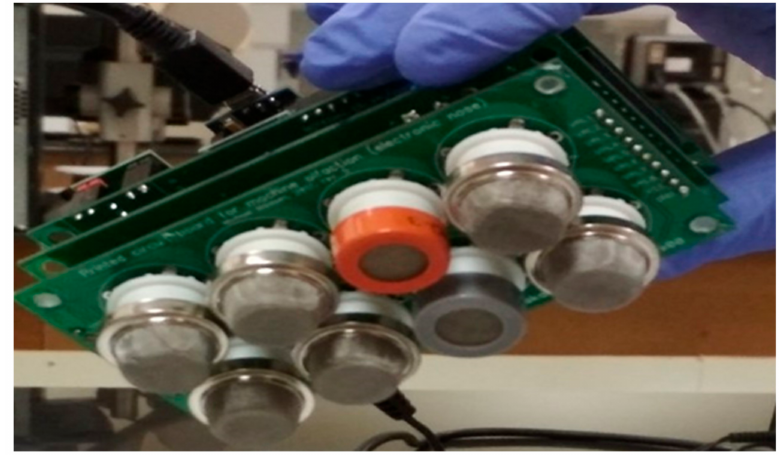
Figure 1. The prototype electronic nose (EN) used in the measurements. It is composed of eight metal-oxide semiconductors (MOS) sensors.